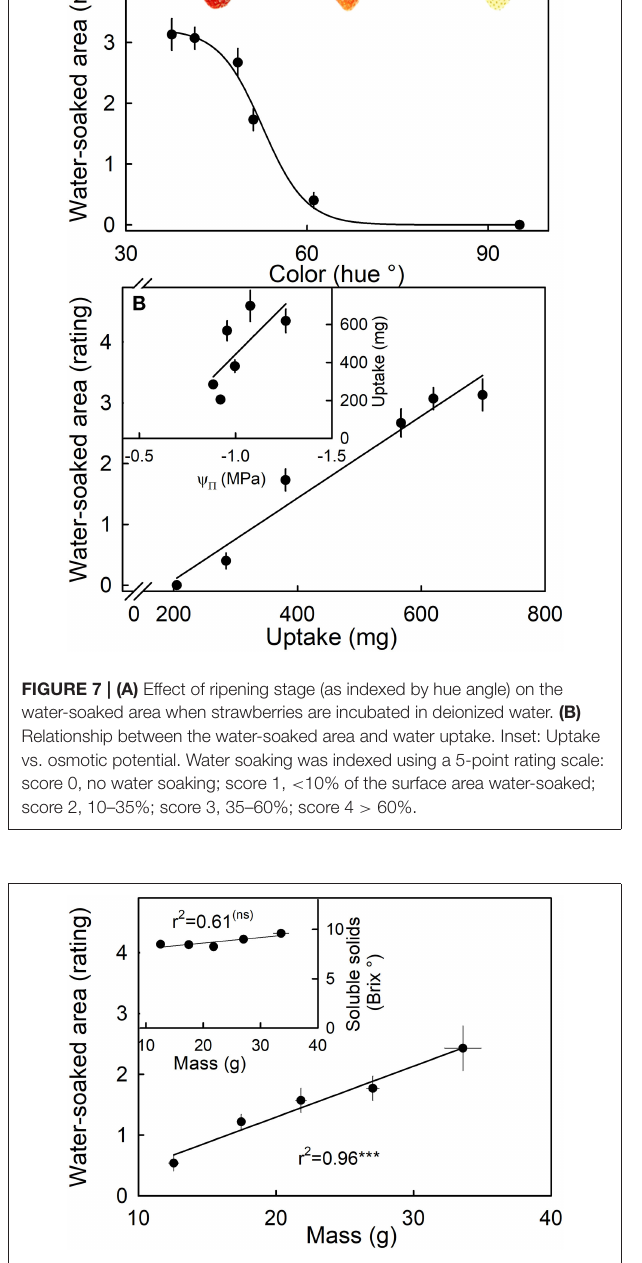
FIGURE 8 | Relationship between water soaking and fruit mass. Inset: Relationship between the soluble solids as indicated by ◦ Brix and water soaking. Water soaking was indexed using a 5-point rating scale: score 0, no water soaking; score 1, < 10% of the surface area water-soaked; score 2, 10–35%; score 3, 35–60%; score 4 > 60%.